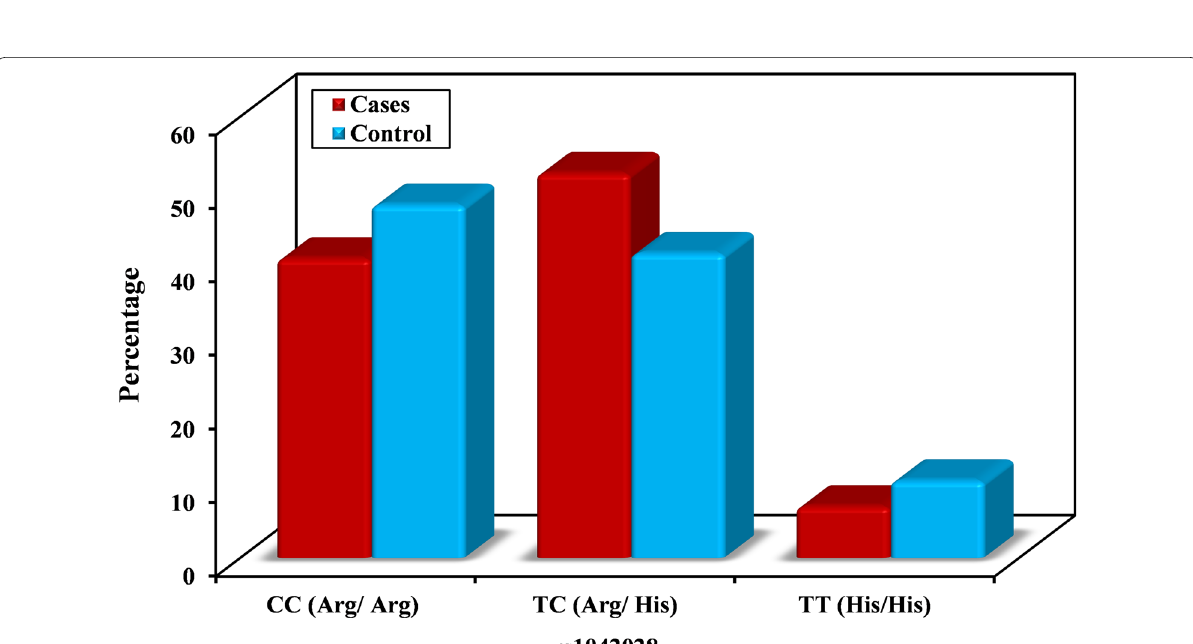
Fig. 2 The genotype distribution of rs1042028 polymorphisms among cases and